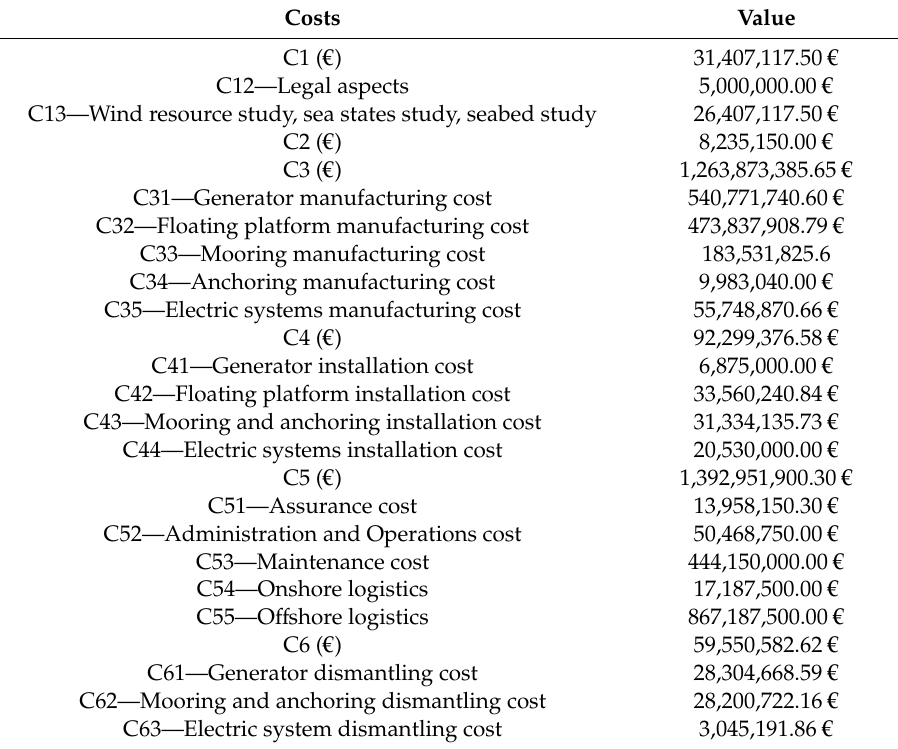
Table 1. Cost estimation for the TELWIND ®